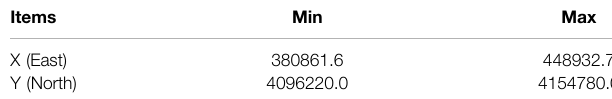
TABLE 2 | Boundaries of the modeling area.